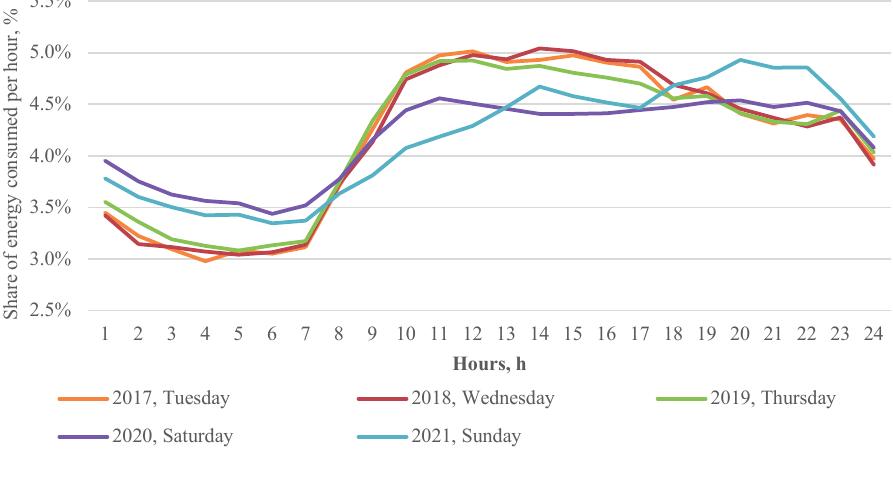
Fig. 2. Electricity consumption share by hours on August 15